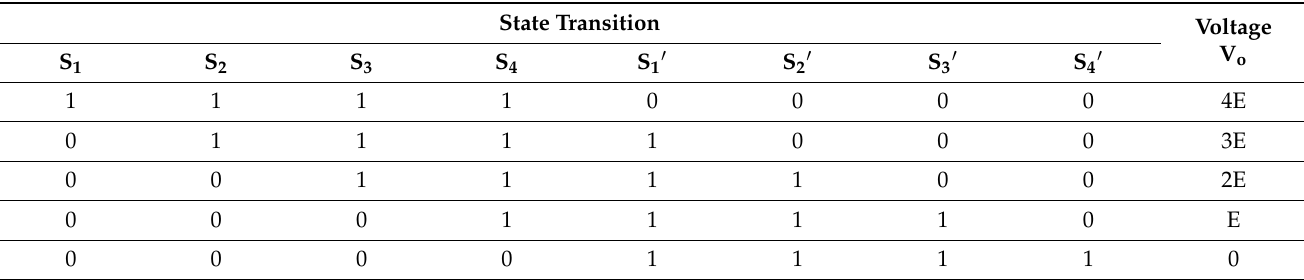
Table 4. A five-level NPC-switching MLI’s states and output voltage.